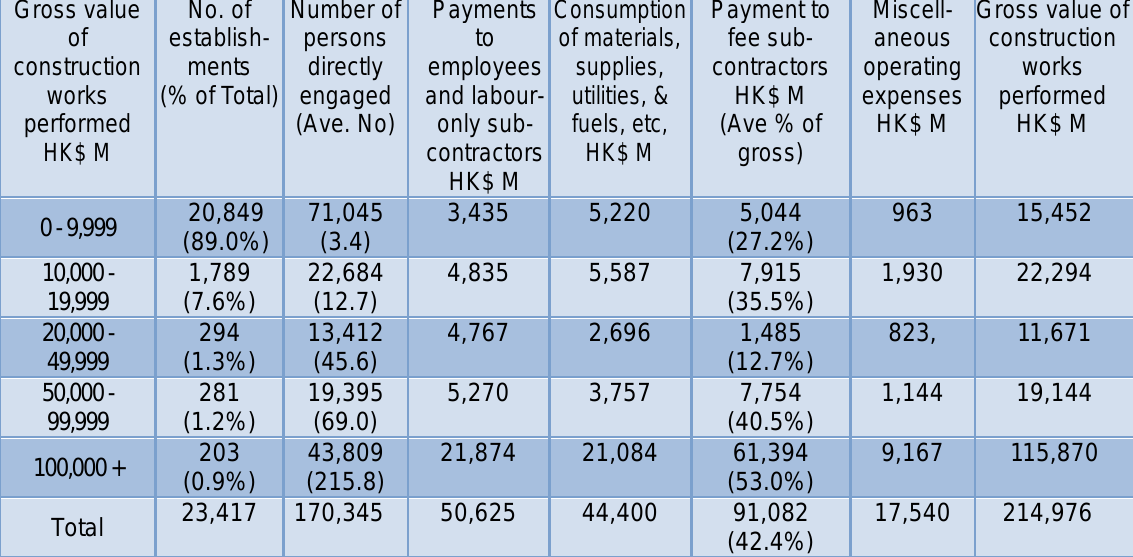
Table 1 Principal statistics for the construction sector by gross value of works performed, 2011 (All figures in HK$ millions) (Source: HKSARCSD 2013a, p. 13) Most sub- contracting firms in the HKCI are part of the small to medium (“SME”)